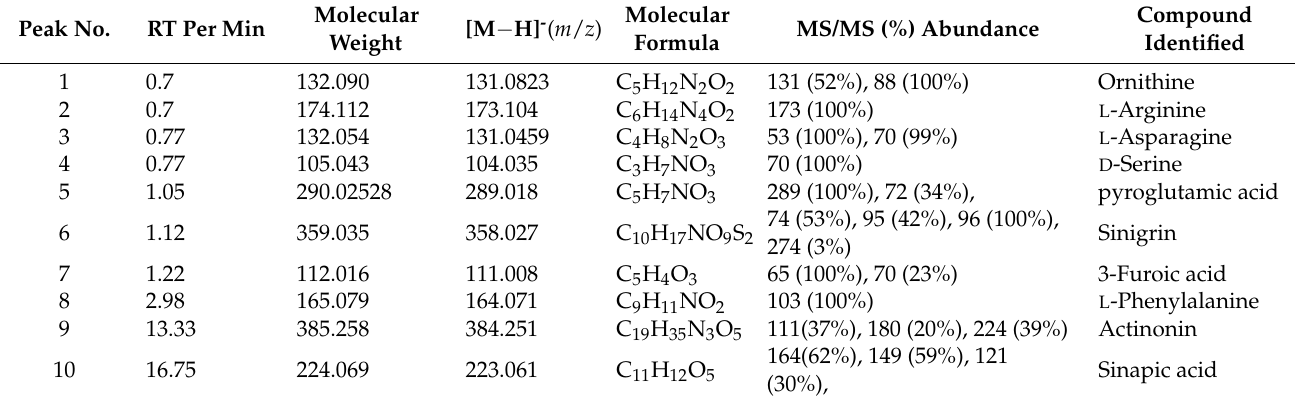
Table 4. Metabolites identified in the ethanol extracts of raw broccoli seeds using UHPLC-Q-TOF-MS2. RT, retention time. Peak No.